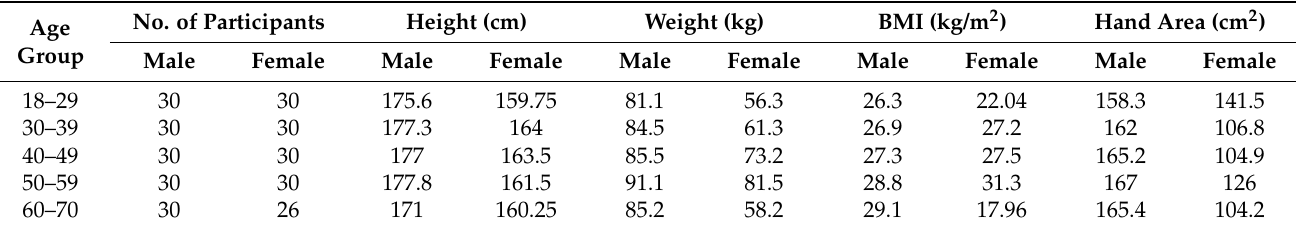
Table 2. Describes participant